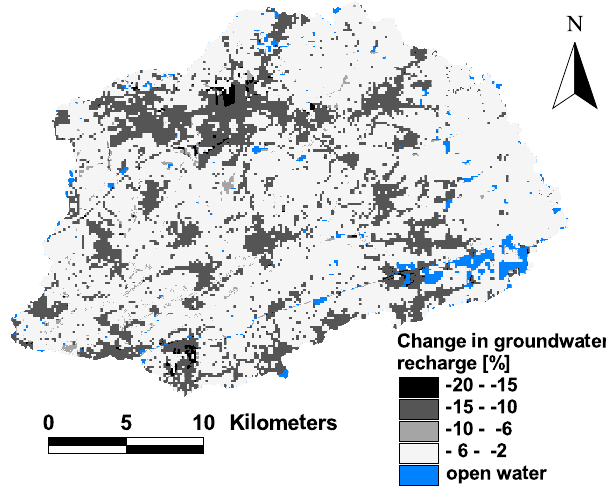
Fig. 9. Spatial distribution of the simulated change (average fu- ture minus reference scenario) in temporally averaged groundwa- ter recharge. Negative changes indicate a decrease in groundwater recharge from the reference status to the average future state.